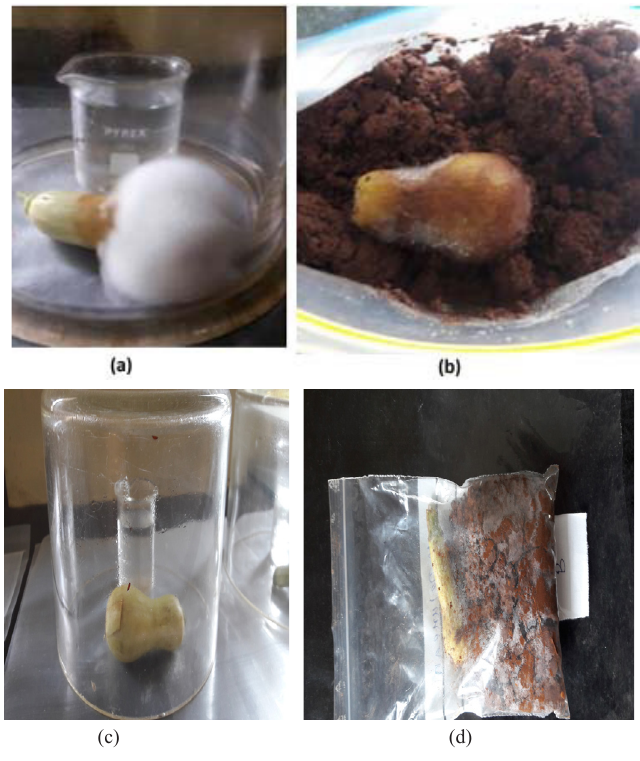
Figure 8: Koch’s postulates to show pathogenicity of the isolates. The inoculated young fruit showed characteristic fruit rot symptom and cottony, pure white color mycelial growth. (a) fruit directly inoculated with the isolate, (b) fruit infected through soil inoculation, (c) and (d) respective controls.